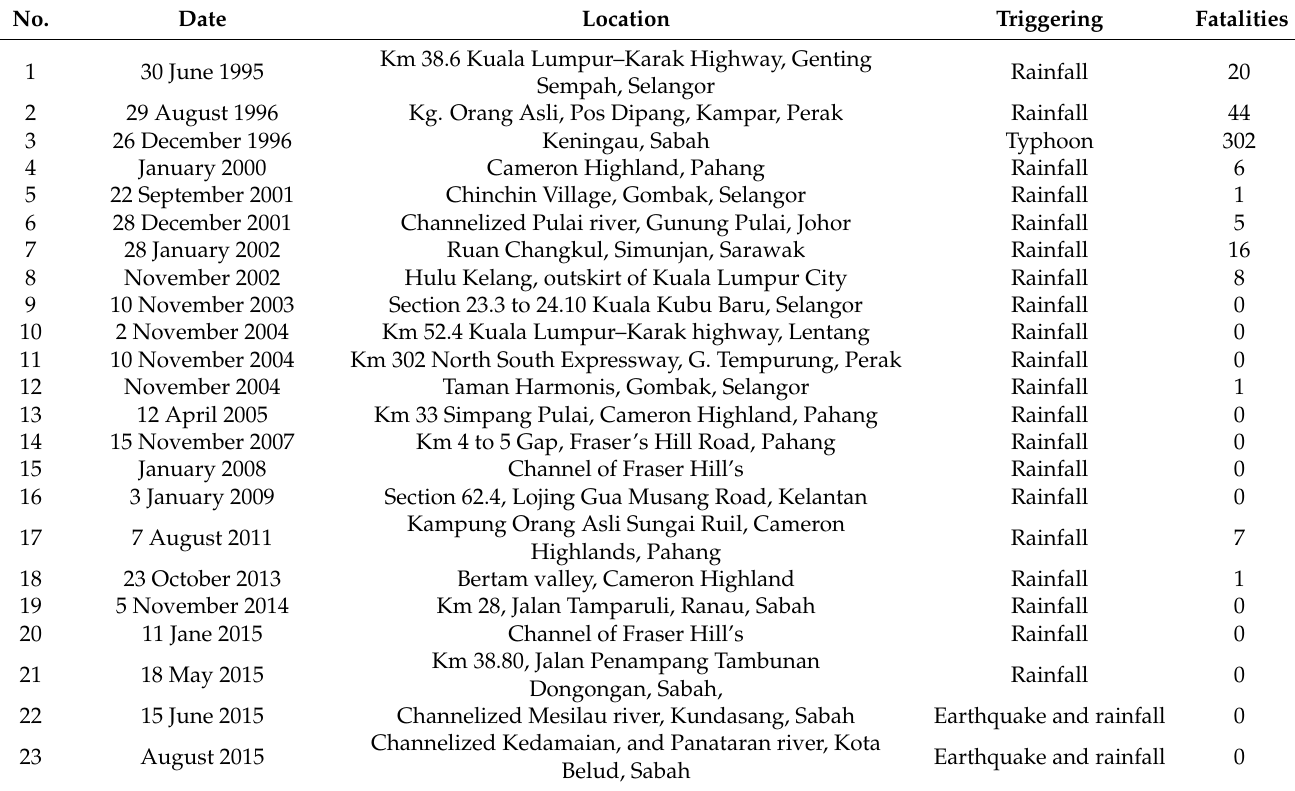
Table 1. Records of debris flows in Malaysia from 1995 to